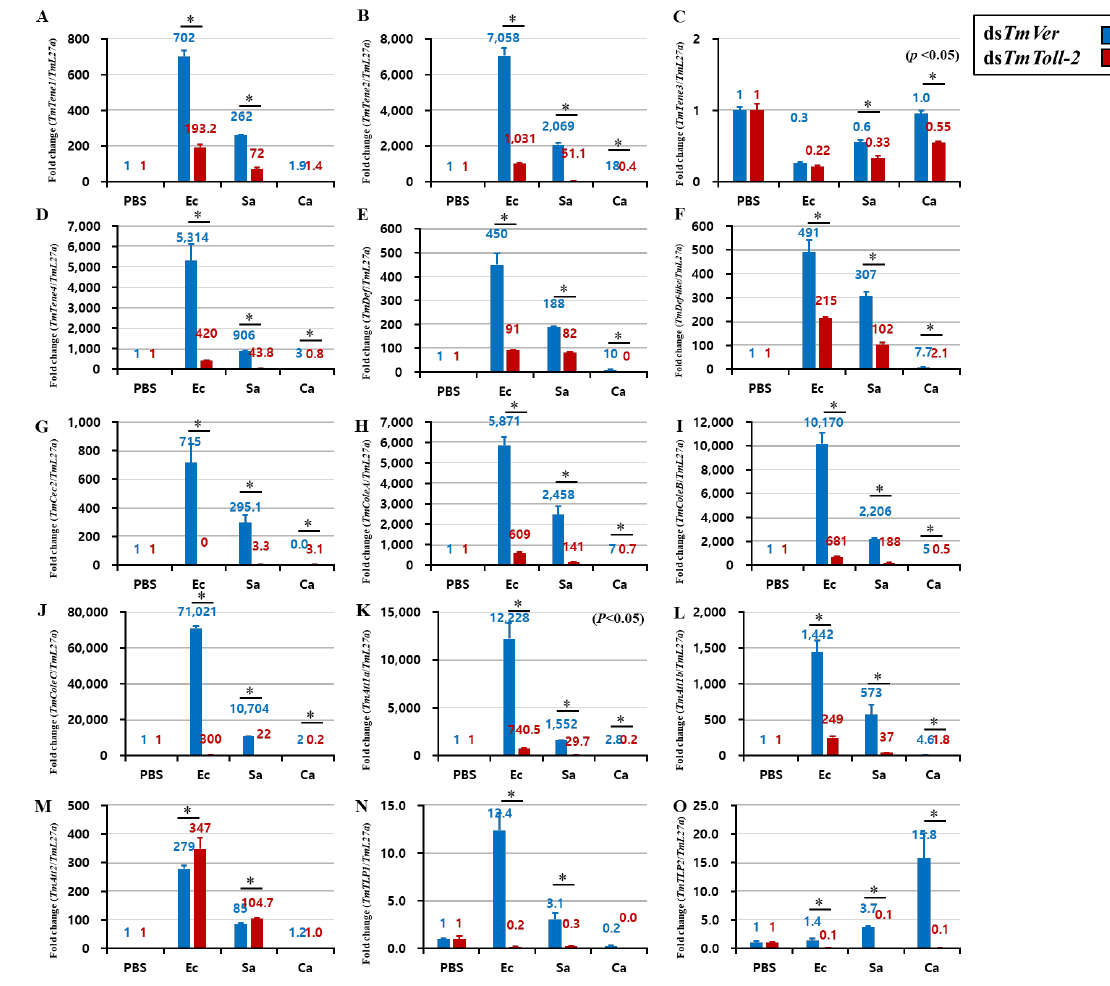
Figure 5. Induction of 15 AMP genes in the fat bodies of TmToll-2 -treated T. molitor larvae infected with E. coli (Ec), S. aureus (Sa), and C. albicans (Ca) by using PBS as a control. At 24 h post microbial injection, AMP genes, including TmTene1 ( A ), TmTene2 ( B ), TmTene3 ( C ), TmTene4 ( D ), TmDef ( E ), TmDef-like ( F ), TmCec2 ( G ), TmColeA ( H ), TmColeB ( I ), TmColeC ( J ), TmAtt1a ( K ), TmAtt1b ( L ), TmAtt2 ( M ), TmTLP1 ( N ), and TmTLP2 ( O ) were examined via qPCR by using ds TmVer as a knockdown control and T. molitor ribosomal protein ( TmL27a ) as an internal control. All experiments were performed in triplicate. Asterisks indicate significant differences between ds TmToll-2 - and ds TmVer RNAi-treated groups determined by Student’s t -test ( p < 0.05).